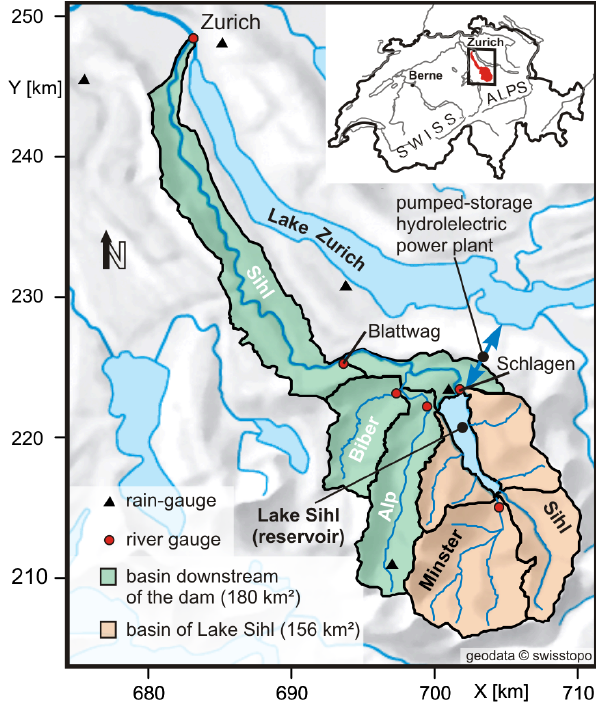
Fig. 1. Map of the Sihl catchment. The nine sub-catchments (in- cluding the one formed by the Lake Sihl) and the available measur- ing stations are shown. Courtesy of J. Schwanbeck, University of